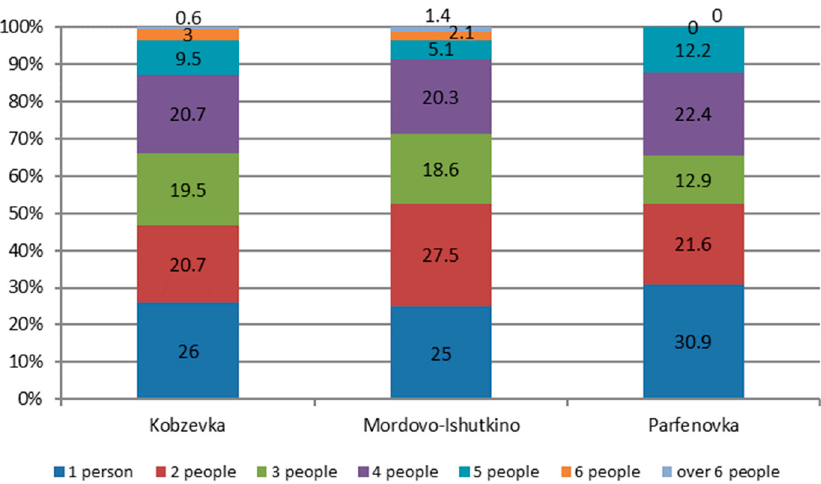
Figure 7. Comparison of private household plots by their quantitative composition in 2014–2018.